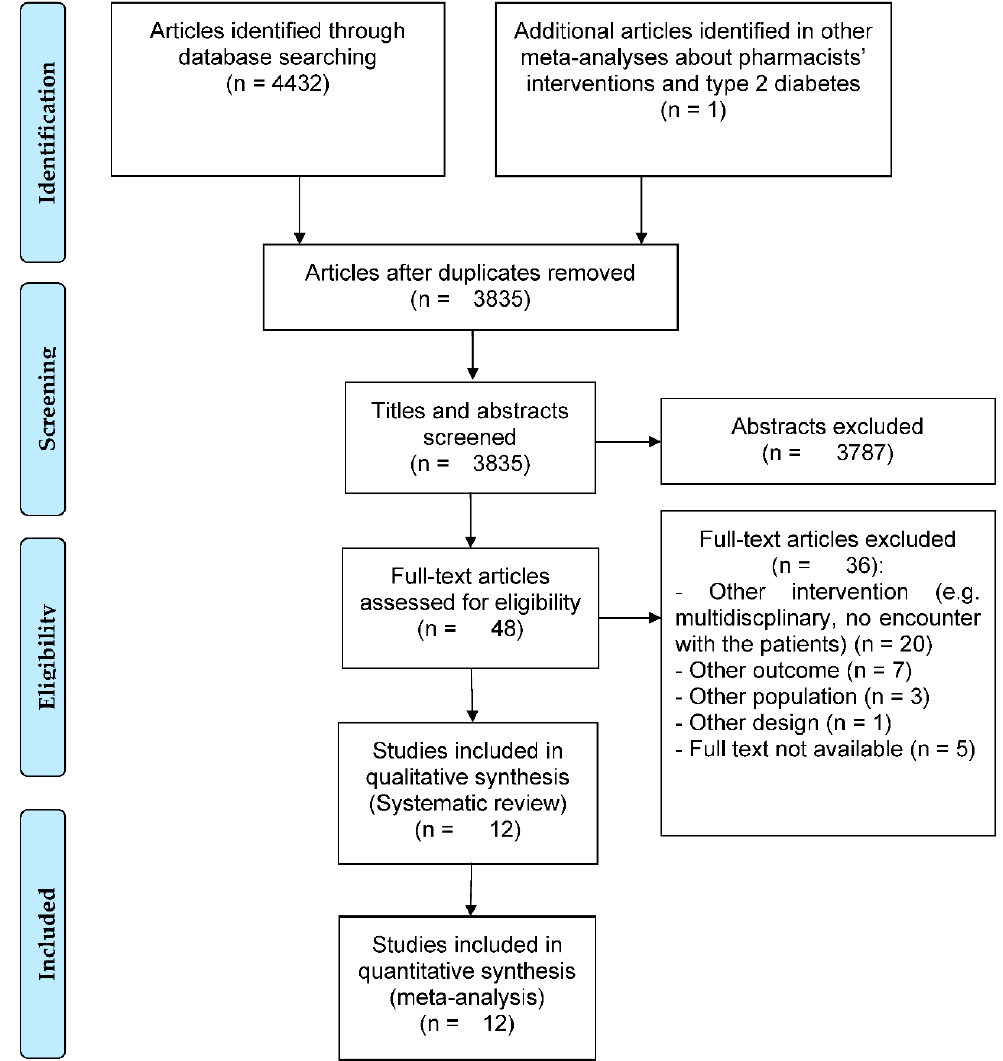
Figure 1. Flow chart of study selection.